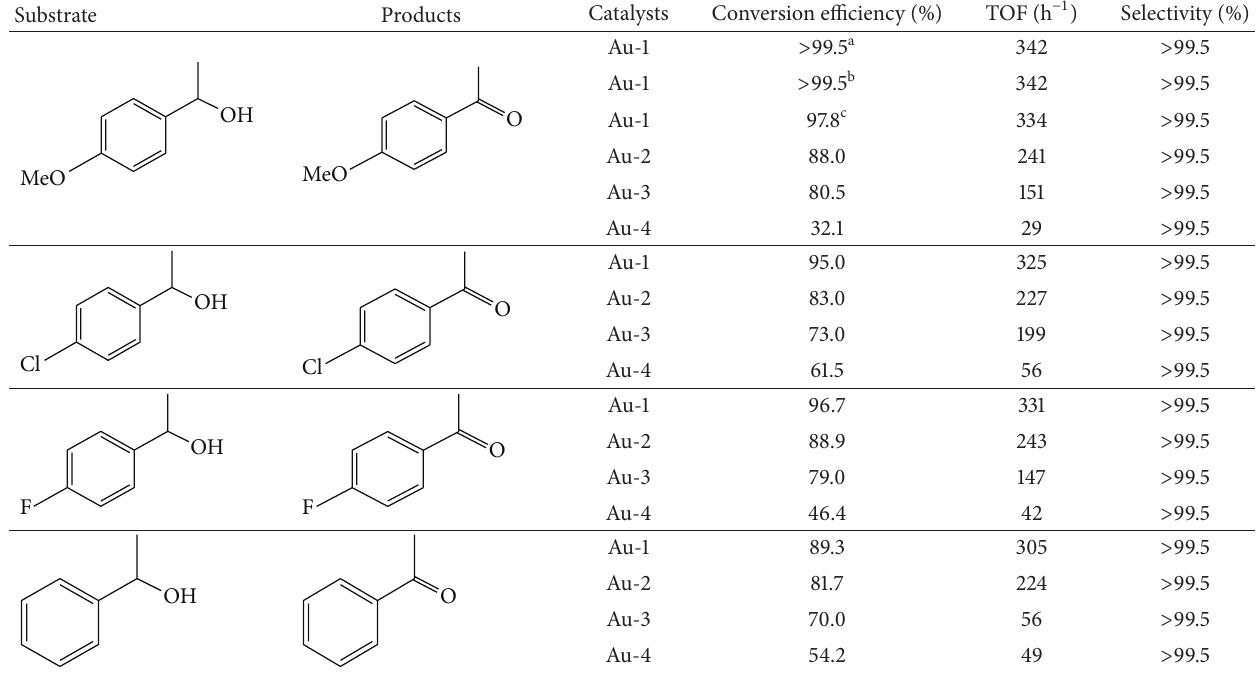
Table 2: Catalytic activities of various Au/OMS samples for aerobic oxidations of 1-phenylethanol and its paraderivates a . Substrate Products